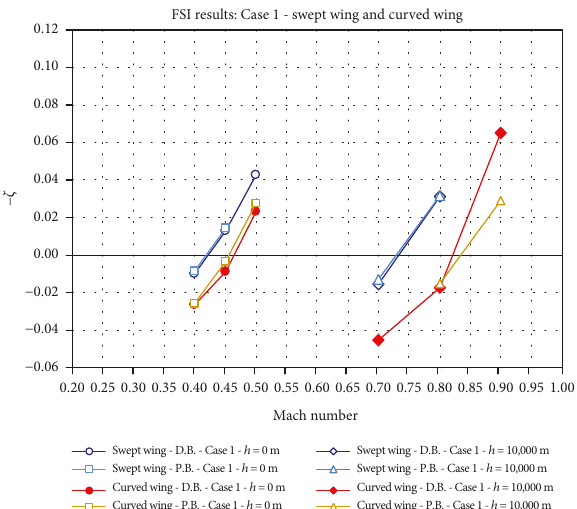
Figure 19: FEM boundary conditions. FSI results: Case 1 - swept wing and curved wing